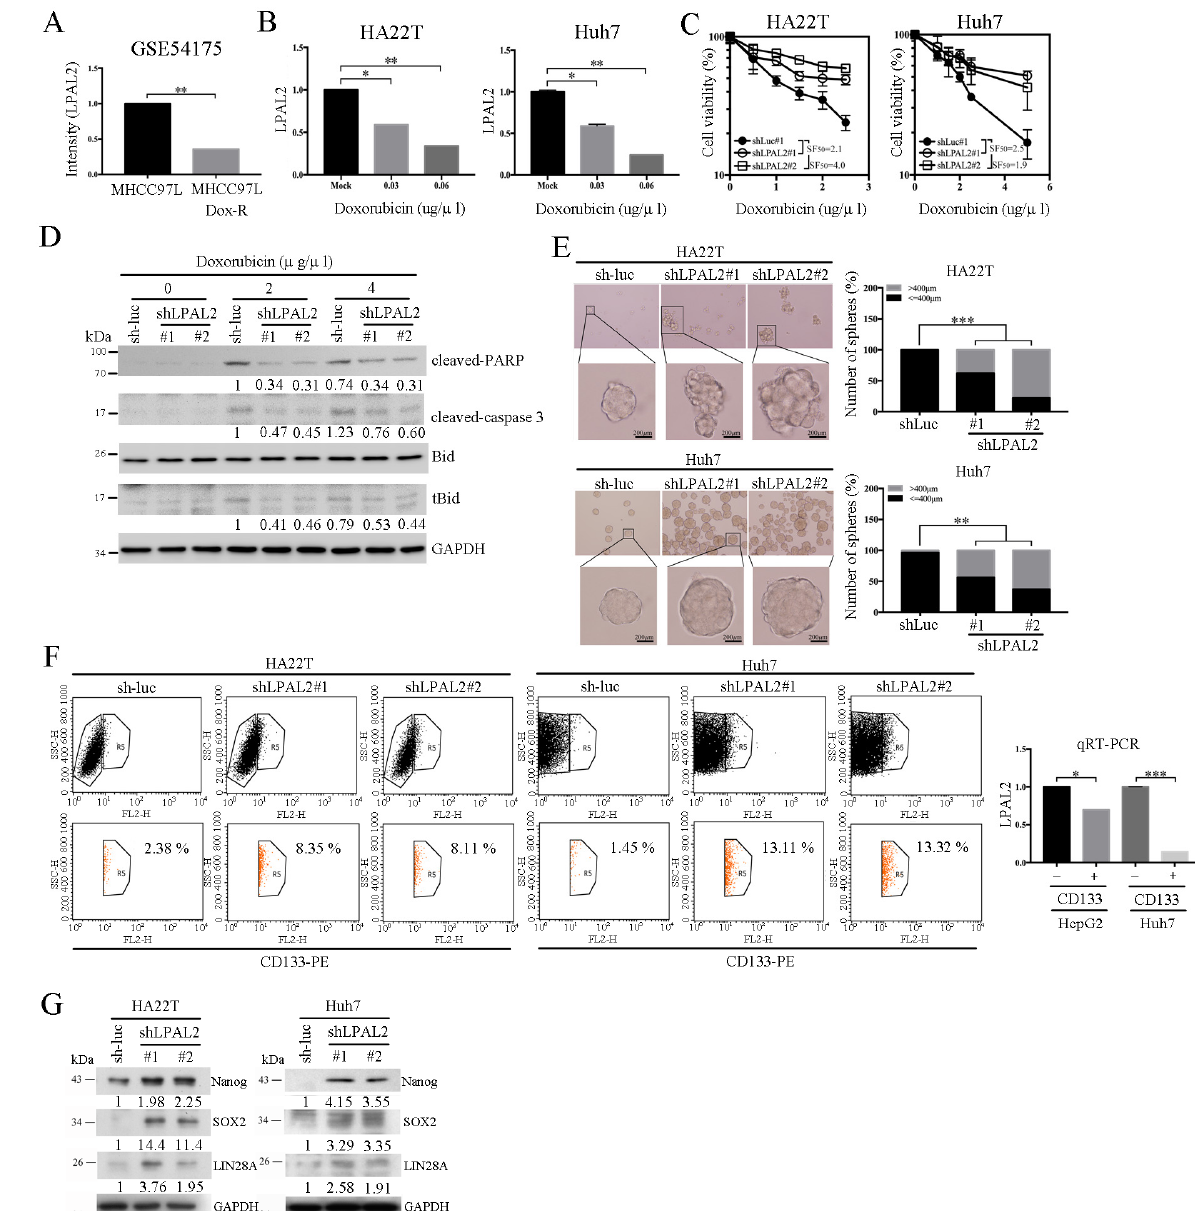
Figure 4. LPAL2 is involved in drug resistance and cancer stem cell phenotypes. ( A ) LPAL2 expression in a doxorubicin-resistant hepatoma cell line, as determined in the online-available GSE54175 dataset. *, p < 0.05; **, p < 0.01. ( B ) Expression level of LPAL2 in HA22T and Huh7 cells treated with doxorubicin, measured using qRT-PCR. 18s rRNA was used as a loading control. ( C ) Cell viability in LPAL2-knockdown cell lines treated with/without doxorubicin was determined by MTT assay. ( D ) Expression levels of PARP, cleaved-PARP, Bid, truncated Bid (tBid) and caspase 3 proteins in LPAL2-depleted HA22T cells with/without doxorubicin treatment were measured by Western blot analysis. GAPDH was used as a loading control. ( E ) Sphere-formation assay in LPAL2-depleted hepatoma cell lines was determined. Sphere size is calculated and shown. **, p < 0.01; ***, p < 0.001. ( F ) Upper panel: CD133 expression in LPAL2 knockdown stable cell line was assayed by flow cytometry. Lower panel: LPAL2 expression in CD133-positive and -negative hepatoma cell lines was measured using qRT-PCR. 18s rRNA was used as a loading control. *, p < 0.05; ***, p < 0.001. ( G ) Expression levels of Nanog, SOX2 and LIN28A proteins in LPAL2-knockdown stable cell lines were measured using Western blot analysis. GAPDH was used as a loading